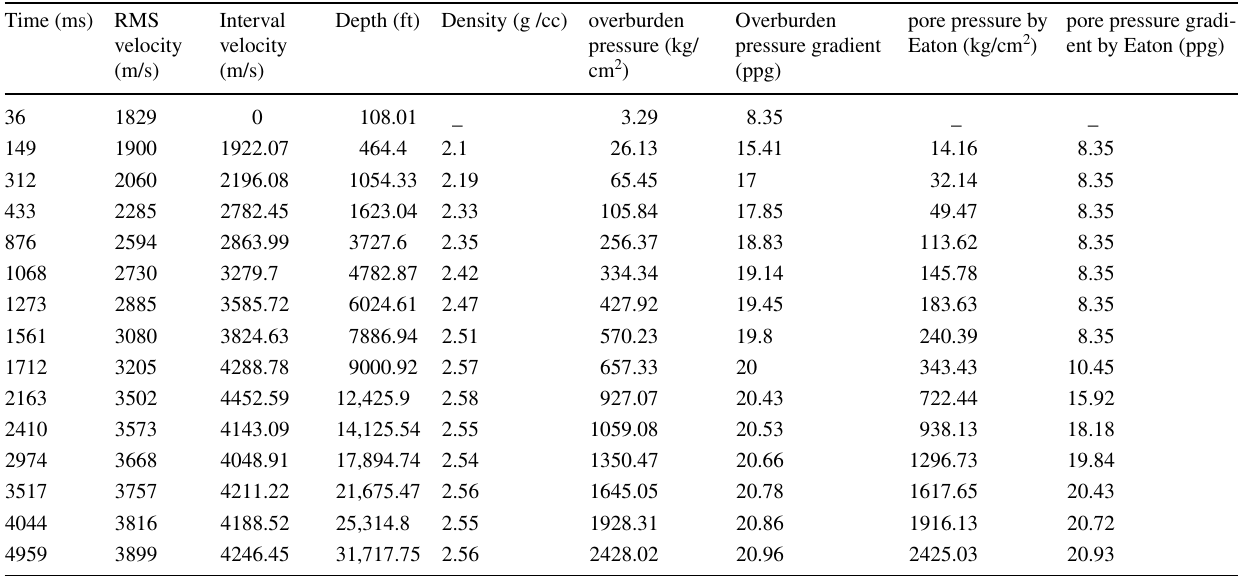
Table 9 Pore pressure prediction by modified Eaton’s